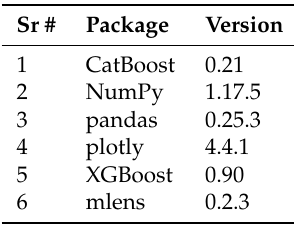
Table 3. Packages used for